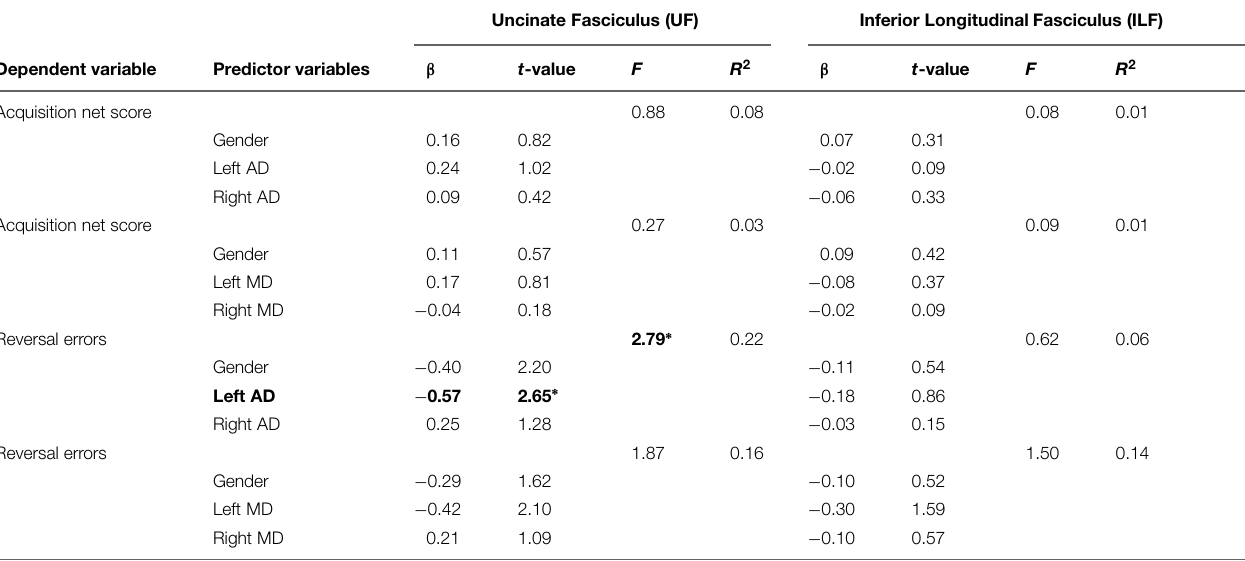
Supplementary Table S2. In summary, no relationship was found linking microstructural properties of the ILF to performance